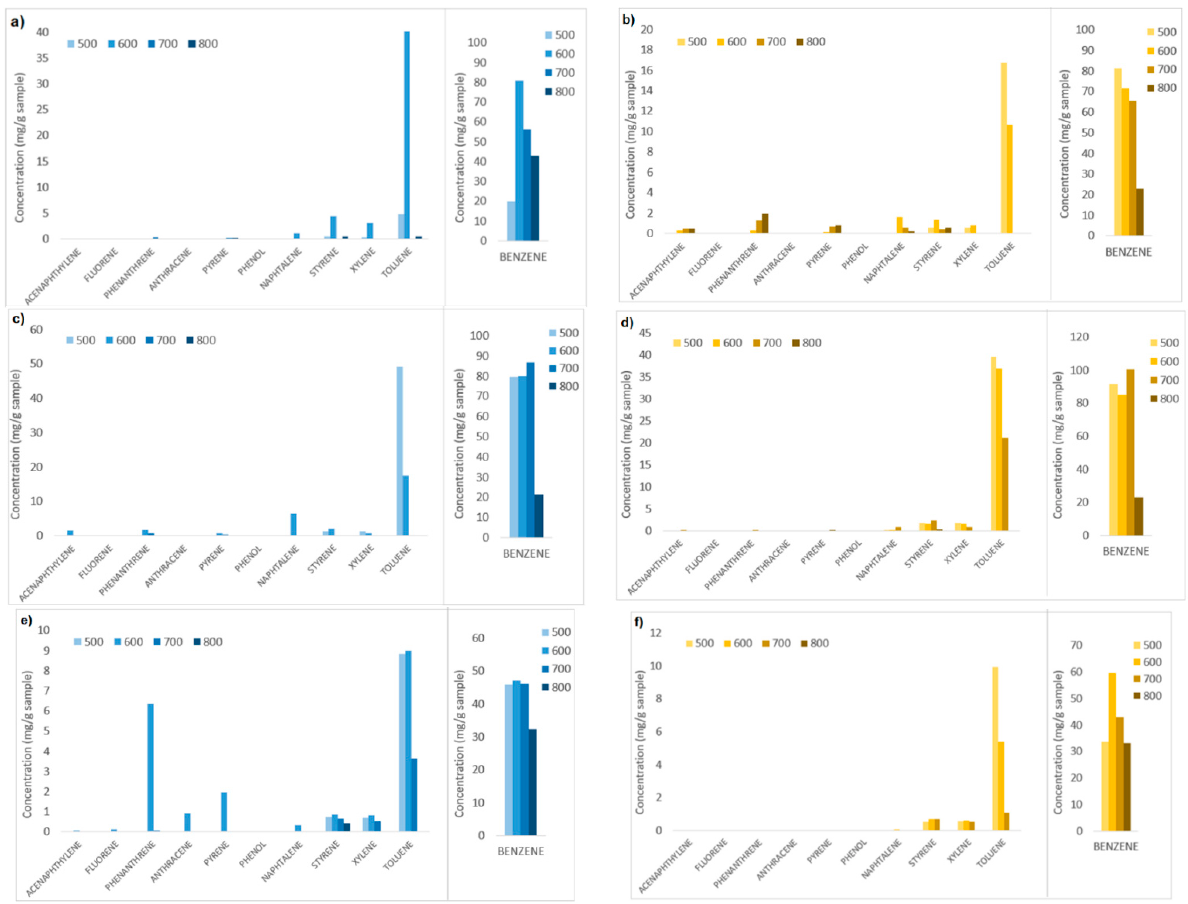
Figure 11. Aromatic hydrocarbon compounds and relative contents obtained in devolatilization tests carried out at different temperatures (500, 600, 700, 800 °C) and fluidizing agents (N 2 , N 2 +air, N 2 +air-wet sample). ( a , b ) Tests with N 2 , chirurgical and FFP2 masks respectively; ( c , d ) tests with N 2 +air, chirurgical and FFP2 masks respectively; ( e , f ) tests of wet samples with N 2 +air, chirurgical and FFP2 masks, respectively.